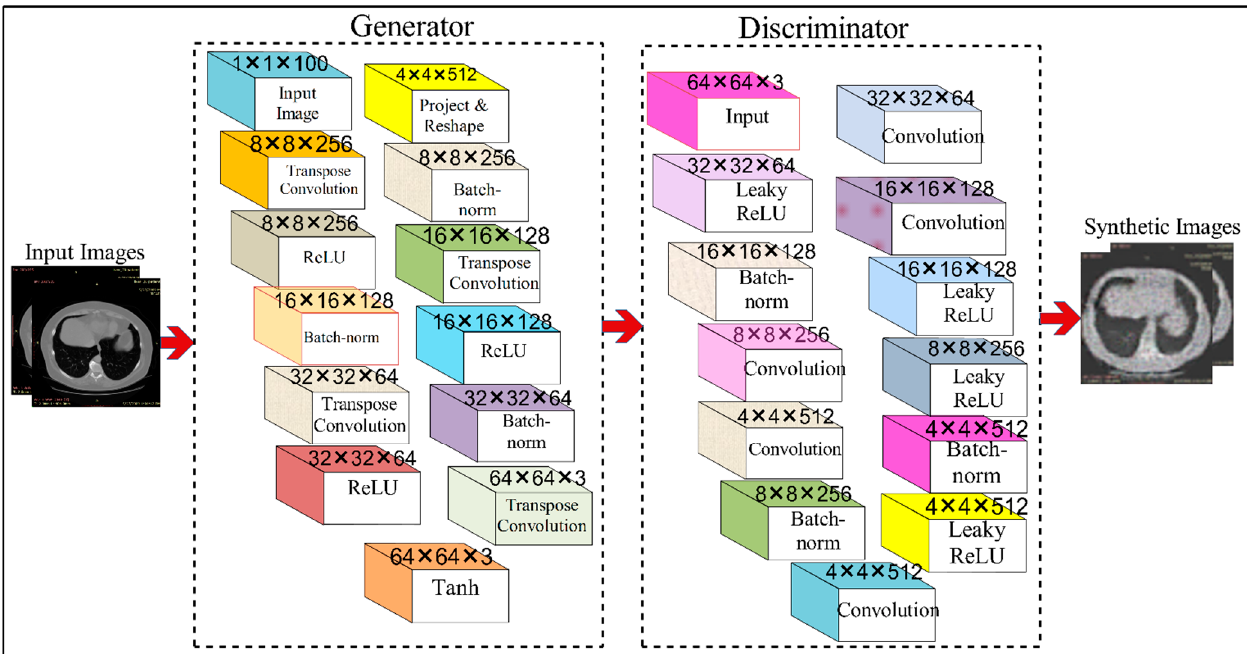
Figure 2. Proposed GAN model steps.